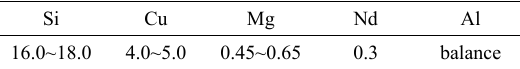
Table 1. Chemical composition of A390-0.3wt%Nd (mass fraction,